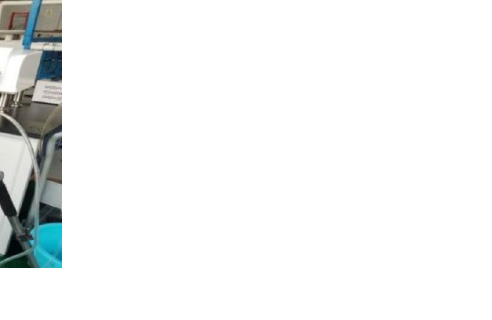
Figure 8. Sprinkler experimental